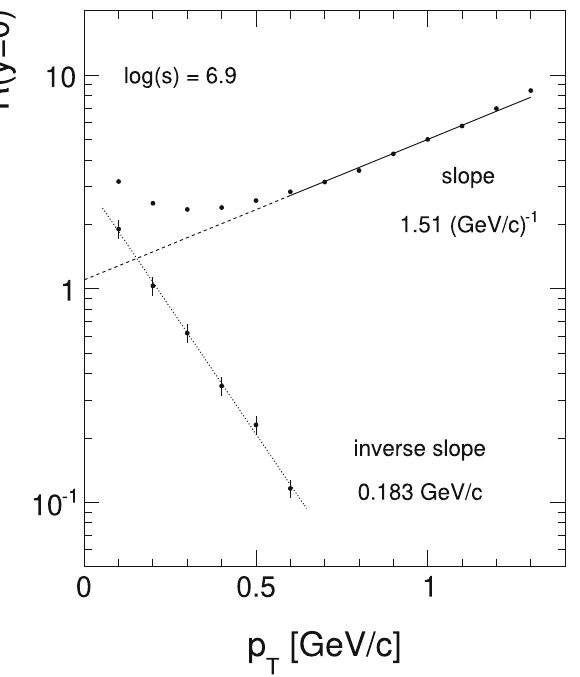
Fig. 124 R ( y = 0 , s , p T ) as a function of p T for log ( s ) = 6.9 with exponential fit to p T > 0.6 GeV/c, extrapolation to low p T (broken line) and subtracted ratio (dotted line)